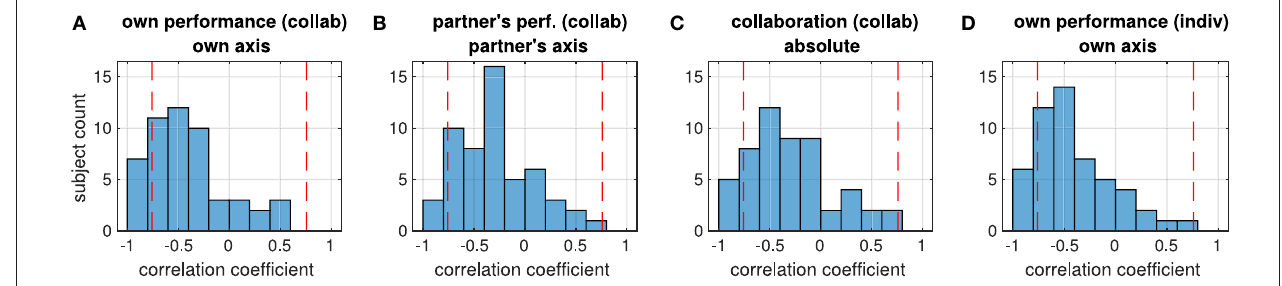
FIGURE 5 | Distribution of correlation coefficients between ratings (given in the first line of the title) and objective performance (tracking error, second title line) of all subjects. Red dashed lines mark the strength beyond which correlations are significant ( p < 0.05, FDR-corrected). Correlations are mostly negative because subjects were asked to rate higher performance, which corresponds to smaller tracking errors, by larger values. The four panels show the distribution of correlations between (A) own performance rating and tracking error on the own axis (collaborative condition), (B) the partner’s performance rating and the tracking error on the partner’s axis, (C) ratings of collaboration and the Euclidean tracking error, (D) own performance rating and tracking error on the own axis (individual condition).